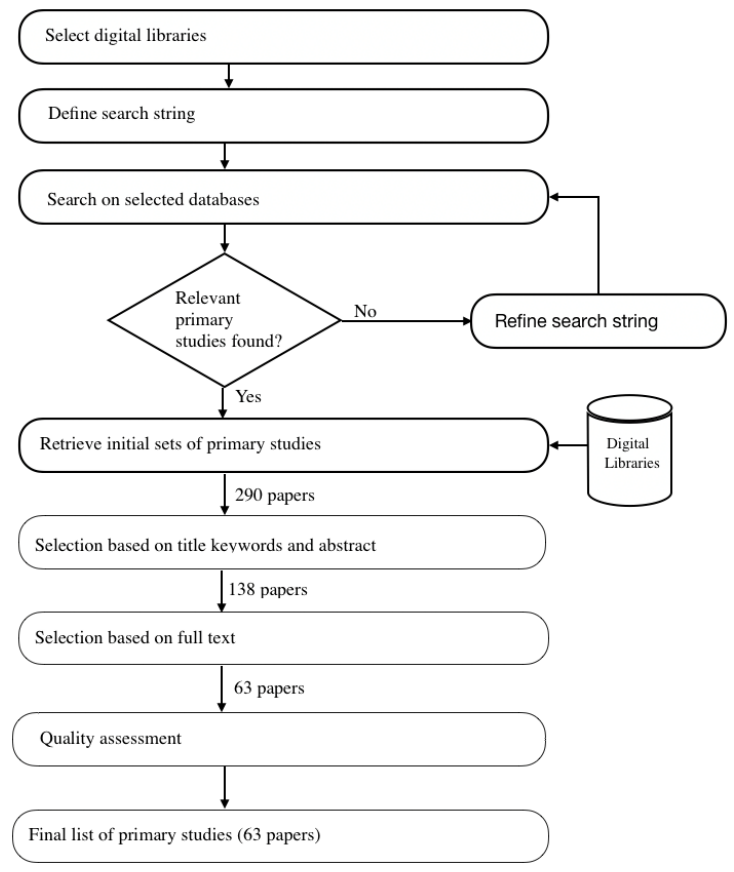
Figure 6. Search and study selection